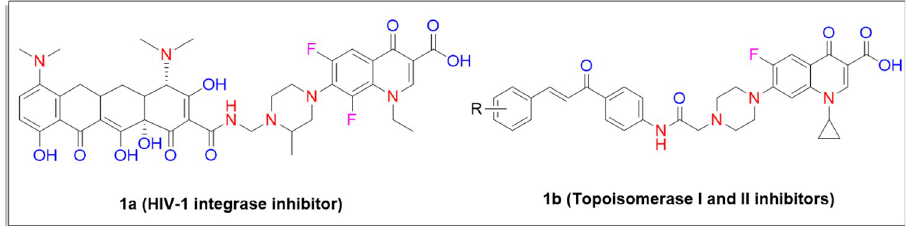
Fig 2. Fluoroquinolones as HIV-1 integrase, topoisomerase I and II